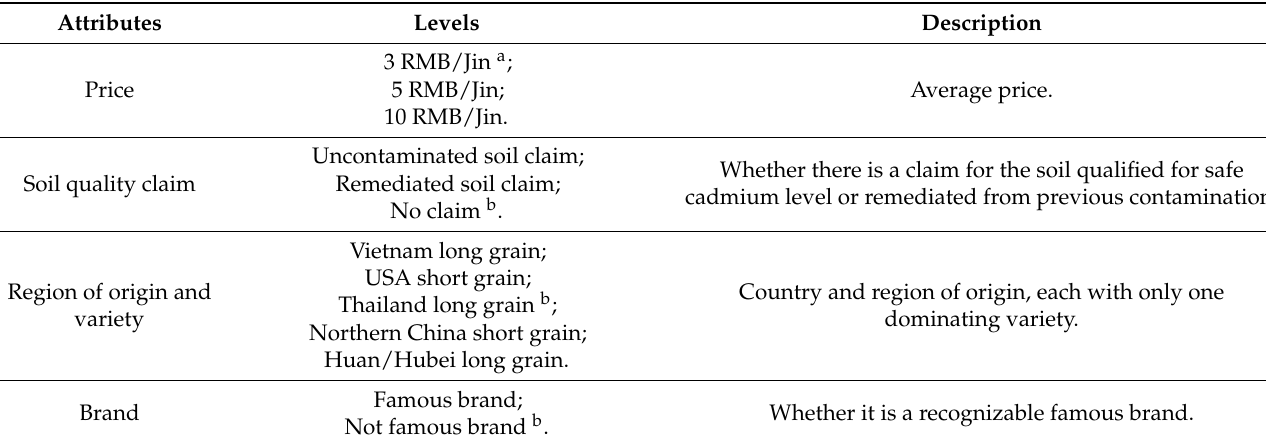
Table 1. Explanation of attributes designed in the choice experiment.